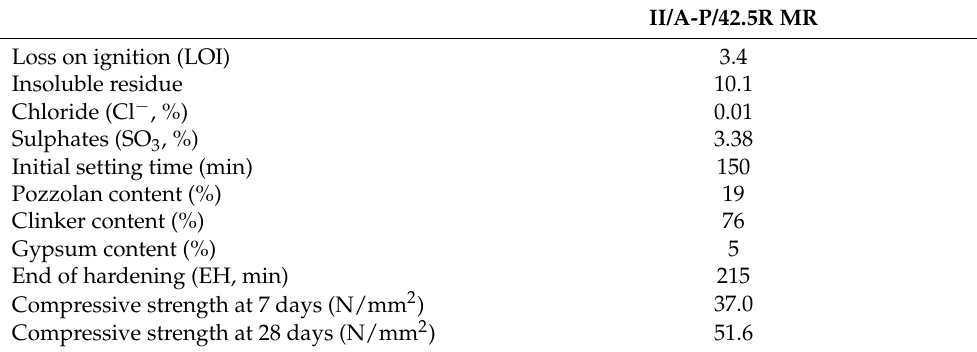
Table 1. Chemical, physical, and mechanical properties of the cement (type II/A-P/42.5R